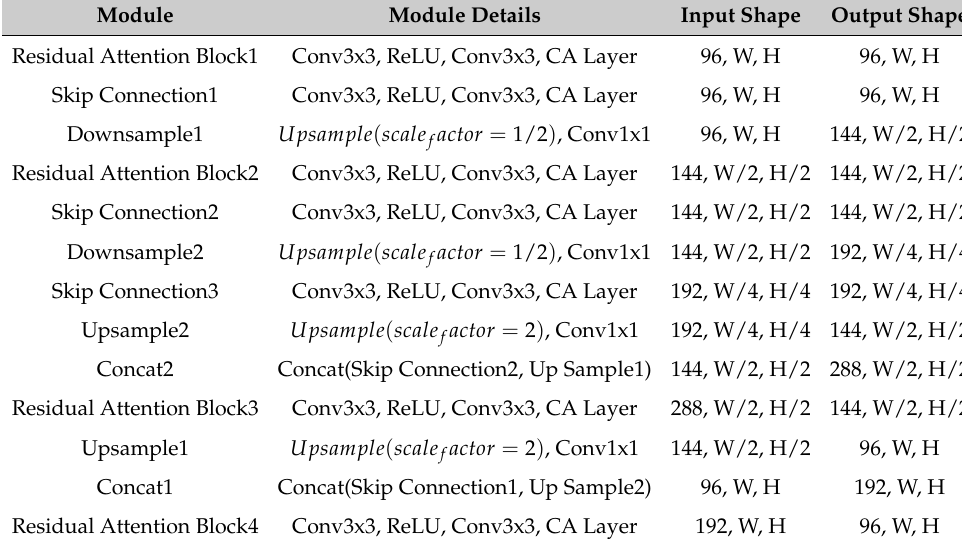
Table 1. Detailed model design of the residual attention branch